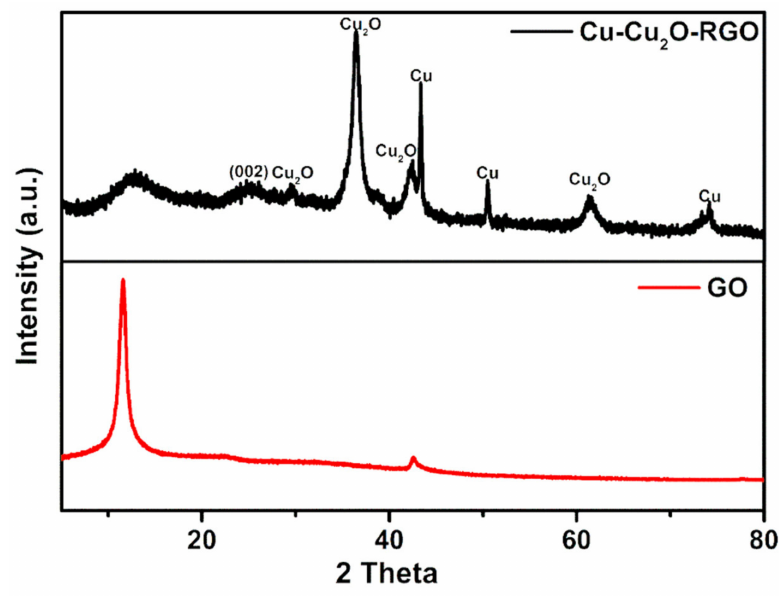
Figure 1. XRD patterns relating to graphite oxide ( bottom ) and RGO/Cu/Cu 2 O composite ( top ). The Raman spectra of the RGO/Cu/Cu 2 O composite and GO are displayed in Figure 2. The two broad peaks observed at 1340 and 1580 cm − 1 originated from the GO and RGO/Cu/Cu 2 O composite and were recognized as the different bands, i.e., D and G, respectively. In general, useful information about the crystallinity degree of different car- bon materials is closely related to the ratio of both bands (ID/IG) [29]. As compared to GO, the RGO/Cu/Cu 2 O composite showed a difference in the intensity ratio I D /I G . The intensity ratio value for GO was 0.90, while that of the RGO/Cu/Cu 2 O composite was 1.23. Owing to the higher ID/IG value for the RGO/Cu/Cu 2 O composite, the degree of crystallinity was better, which can be attributed to the materialization of different and lesser sp 2 dominions during reduction compared with the GO [30].